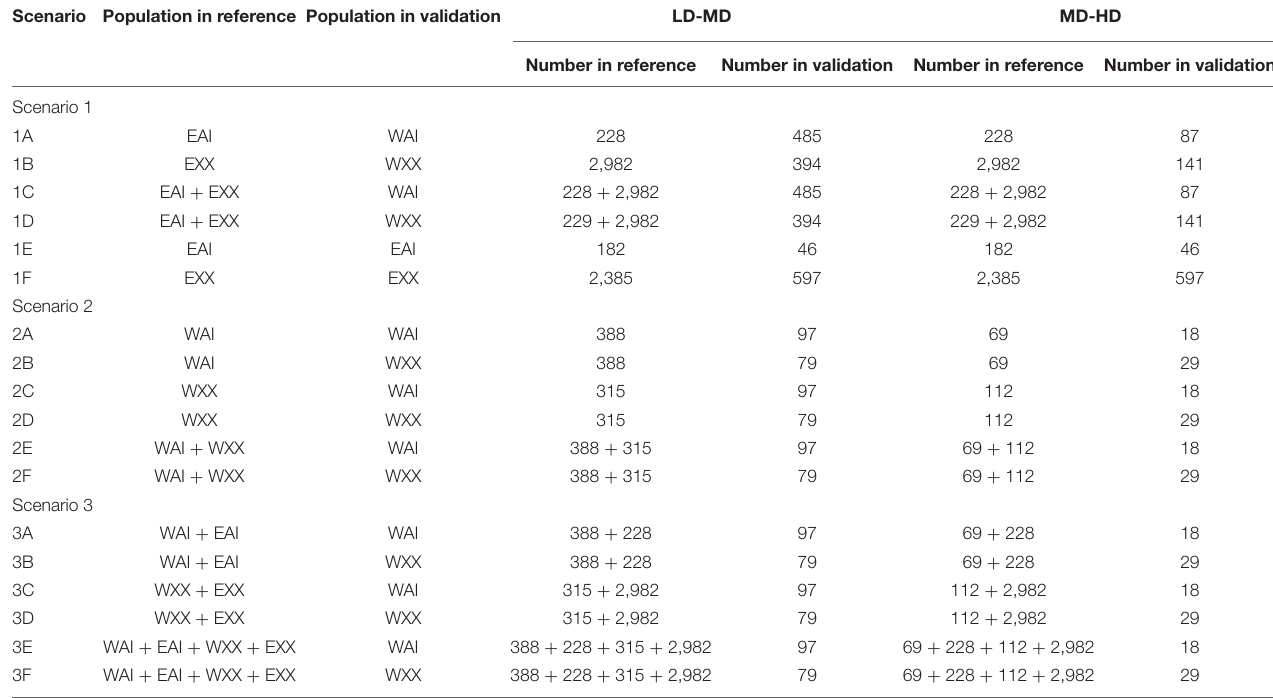
TABLE 2 | Scenarios and the number of animals used in the reference and validation sets to assess imputation accuracy. Scenario Population in reference Population in